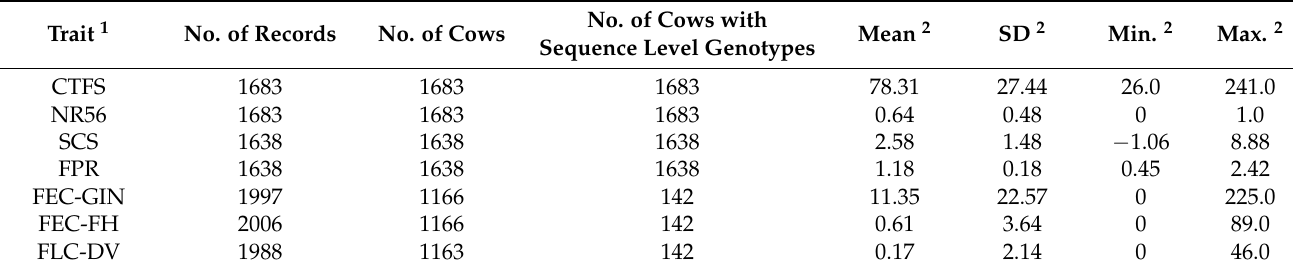
Table 1. Descriptive statistics for fertility traits, health and metabolic stability indicator traits, and endoparasite infection traits in